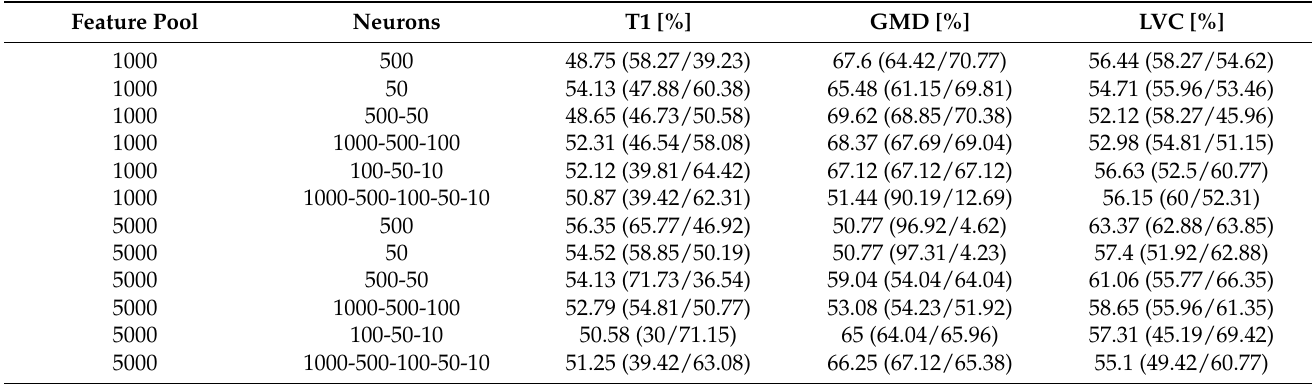
Table 2. Results for SAE learned on the three types of features (T1, GMD, and LVC). The metrics listed represent the accuracy (sensitivity/specificity) in percentage.